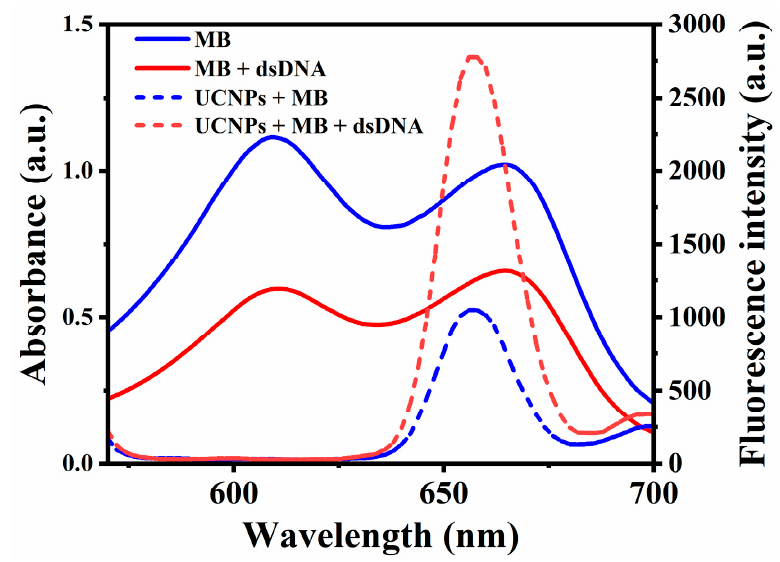
Figure 2. UV-Vis absorption spectra of the MB and MB + dsDNA; upconversion fluorescence spectra of UCNPs + MB and UCNPs + MB + dsDNA.